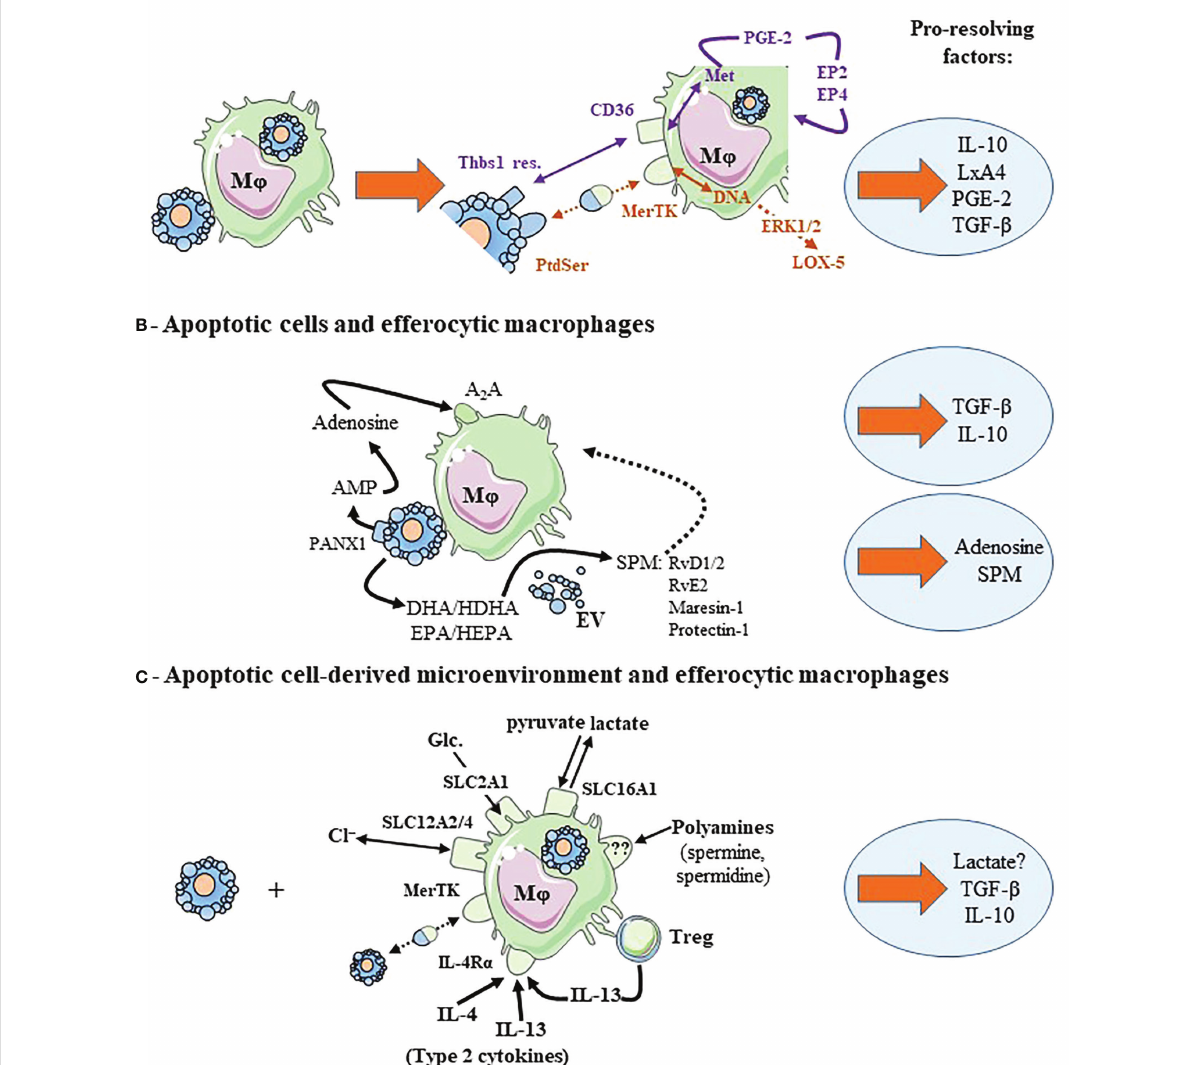
FIGURE 2 Cooperative mechanisms implicating efferocytic macrophages contributes to macrophage reprogramming and to the release of pro-resolving factors. (A) Recognition of apoptotic cell surface molecules by their cognate receptors and metabolites generated from digested apoptotic cells cooperate to induce macrophage reprogramming and pro-resolving factor release. Two examples are given corresponding to two different colors: DNA and recognition of PtdSer by MerTK in brown color, and methionine (Met) and recognition of thrombospondin-1 residues (Thbs1 res.) by CD36 in purple. We illustrated also the autocrine loop leading to TGF- b secretion implicating PGE-2 and its receptors, EP2 and EP4. (B) Efferocytic macrophages cooperates with apoptotic cells. Each cell contributes to macrophage reprogramming and the secretion of pro-resolving factors. This is the case of adenosine conversion by macrophages from AMP (adenosine mono-phosphate) released in the extracellular milieu by apoptotic cells through the Pannexin-1 (PANX1) channels. Apoptotic neutrophils or extracellular vesicles (EV) issued from these apoptotic neutrophils participate in the transcellular biosynthesis of specialized pro-resolving lipid mediators (SPM) by macrophages. Apoptotic neutrophils or EV provide SPM precursors (not necessarily DHA or EPA, but other intermediate precursors [HDHA and HEPA, respectively]) that are transformed in SPM by efferocytic macrophages. (C) Efferocytic macrophages may require signals from their microenvironment to acquire a pro-resolving pro fi le and secrete pro-resolving factors. This microenvironment may correspond to ions (chloride, Cl − ), Glucose (Glc.) or their metabolites regulated through solute carrier transporter (SLC) exchange, polyamines, the presence of type 2 cytokines or regulatory T cells (Treg). Dotted arrows correspond to a suspected and indirect link. Pro-resolving factors are identi fi ed by light blue circles. For more details, please see the text. Other abbreviations: A2A, Adenosine 2A receptor; DHA, docosahexaenoic acid; EPA, eicosapentaenoic acid; EP, prostaglandin-E2 receptor; ERK, extracellular signal-regulated kinase 1/2; HDHA, hydroxy-docosahexaenoic acid; HEPA, hydroxy-eicosapentaenoic acid; IL-4R a , interleukin-4 receptor-alpha; LxA4, Lipoxin A4; M j , macrophage; PGE-2, prostaglandin-E2; RvD1/2, resolvin D1 and resolvin D2; RvE2, resolvin E2. This fi gure was depicted, in part, by using Servier Medical Art,